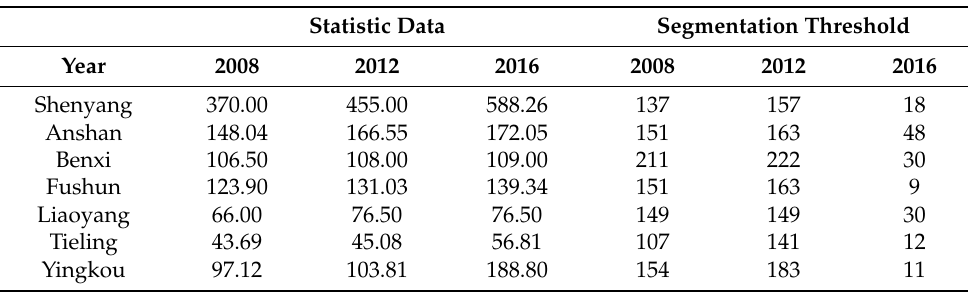
Table 1. Statistical data of urban built-up areas (km 2 ) and optimal segmentation threshold of central Liaoning urban agglomeration.